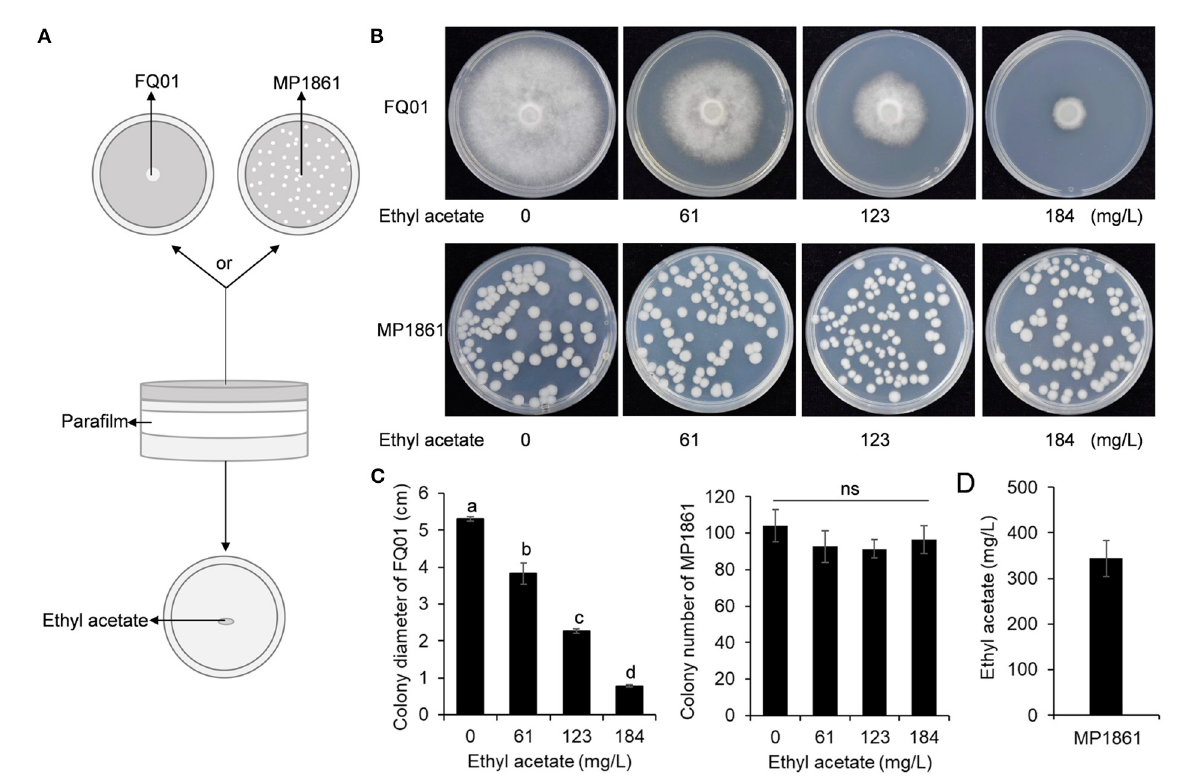
FIGURE5 Antifungal activity of ethyl acetate in the airspace against P. nicotianae FQ01. (A) Procedure used in this study. (B) Colonies of the oomycete strain FQ01 and the yeast strain MP1861 grown on PDA plates for 4 d. (C) Colony diameter of the pathogen FQ01 and colony number of the yeast strain MP1861. Three experiments were carried out. Different letters (a, b, c, and d) labeled on the columns are significant difference at p < 0.05. Probability values of more than 0.05 were marked as ns (no significance). (D) Ethyl acetate production in the VOCs of the yeast strain